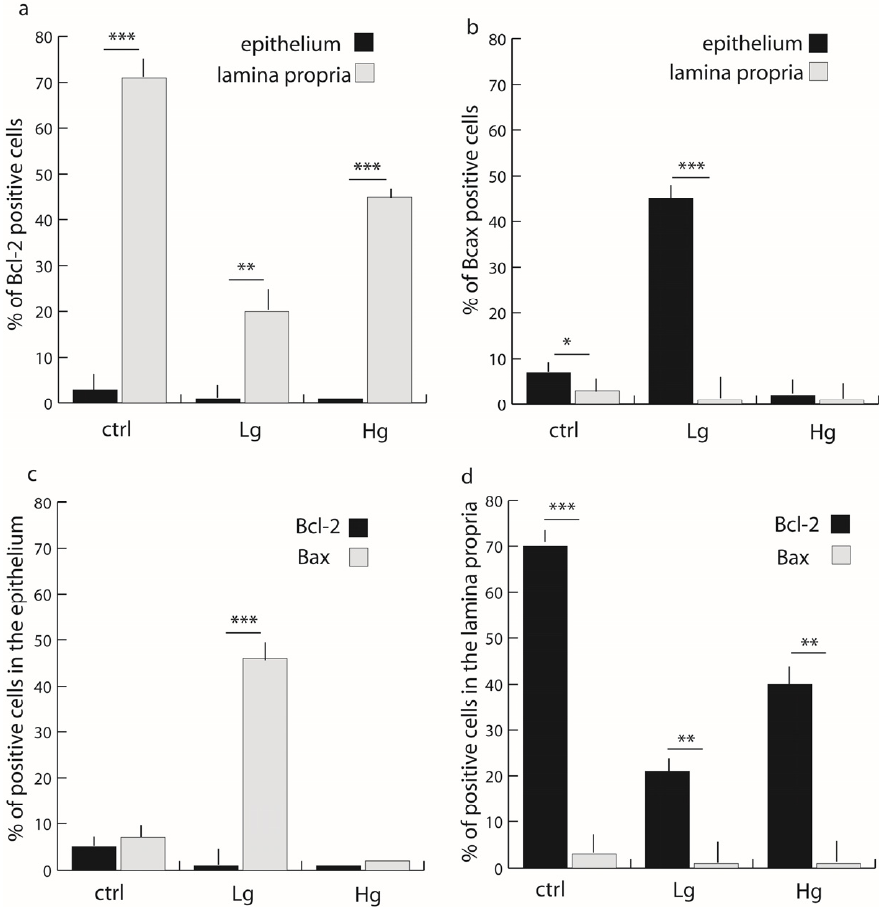
Figure 3. Distribution of Bcl-2- ( a ), and Bax- ( b ) positive cells in the lamina propria (lp) and epithelium (e), and distribution of Bcl-2- and Bax-positive cells in the epithelium ( c ) and lamina propria ( d ) in control colon tissue (ctrl), low-grade colon cancer (Lg), and high-grade colon cancer (Hg). Data are presented as mean ± SD. Significant differences (Mann–Whitney test) are indicated by * p < 0.01, ** p < 0.001, *** p < 0.0001.